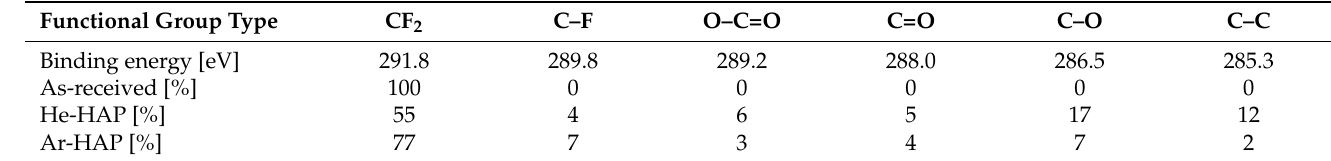
Figure 4. C1s-XPS spectra of the PTFE samples HAP-treated using He or Ar gas. ( a ) As-received PTFE, ( b ) He-HAP-treated PTFE, and ( c ) Ar-HAP-treated PTFE. Table 2. Functional-group ratios of the PTFE samples HAP-treated using He or Ar